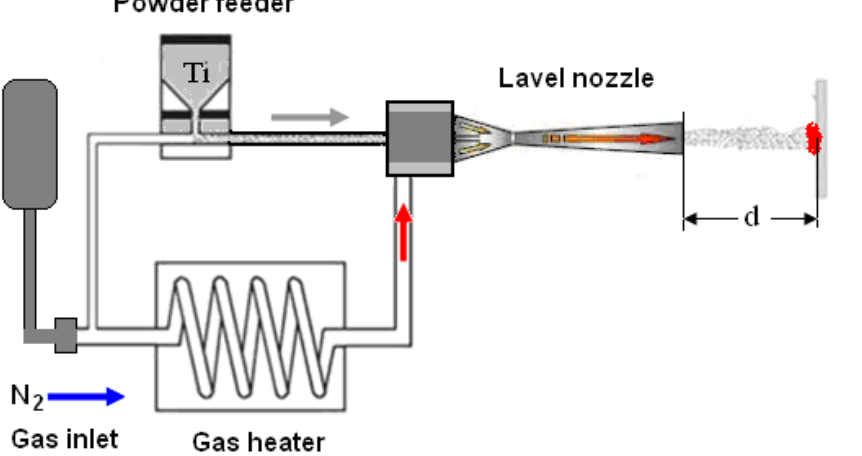
Figure 2. Typical cold spray equipment with a marked distance of the nozzle from the sample surface.